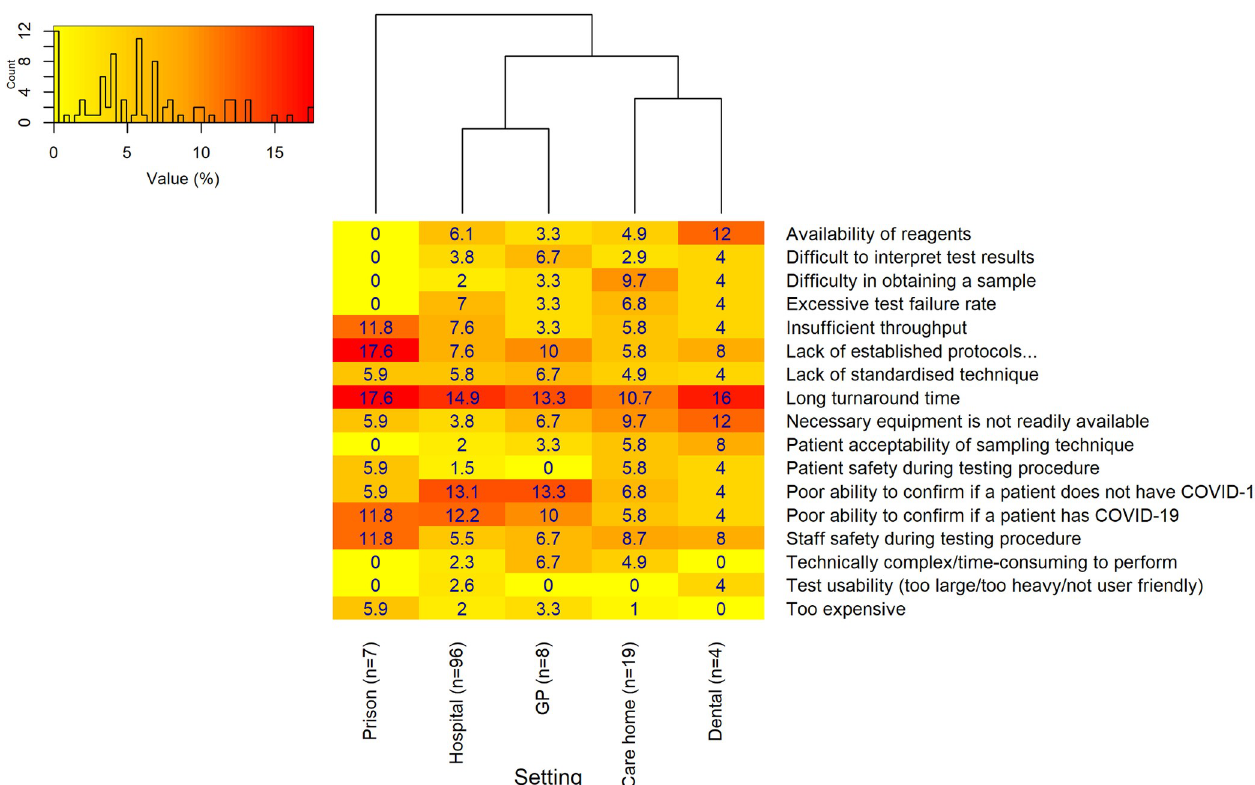
Fig 5. Most important perceived problems associated with COVID-19 testing in each setting. Primary and secondary dental settings were merged, in addition to care homes with and without nursing. The ‘Hospital-at-home’, hospice and ambulance setting (n < 15) were excluded due to the small number of overall respondents. A hierarchical cluster analysis indicates how similar/dissimilar the perceived problems associated with COVID-19 testing are between settings. The numbers of responses from individual settings for this particular question are displayed on the x axis (n = x). The histogram in the top left of the plot area shows the distribution of values, and provides a key to indicate the specific color shade of different